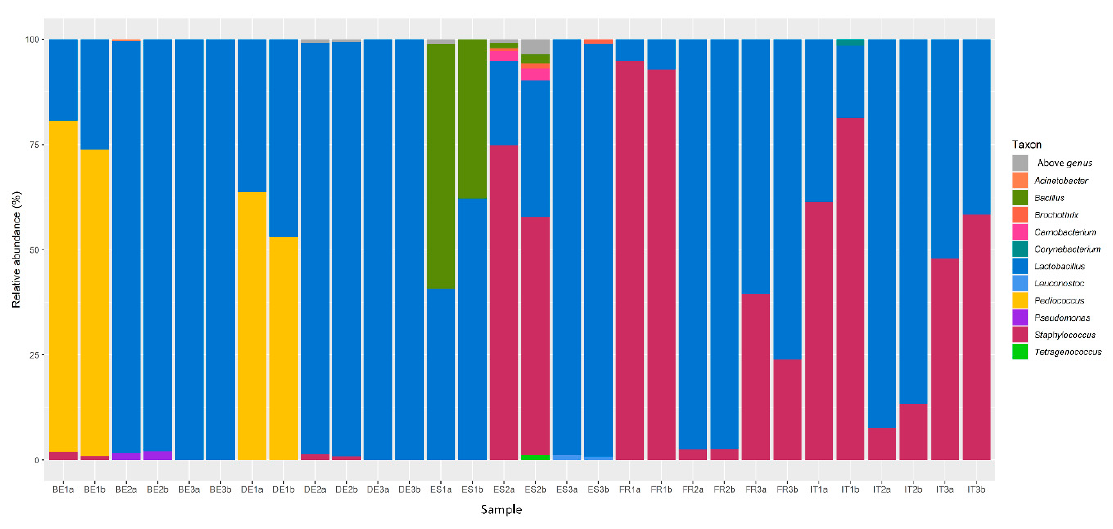
Figure 1. Distribution of amplicon sequencing variants (ASVs) of the V4 region of the 16S rRNA gene in selected commercial fermented meat products originating from BE (Belgium), DE (Germany), ES (Spain), FR (France), and IT (Italy), with “a” and “b” annotations in the sample names representing biological duplicate samples from the same product.